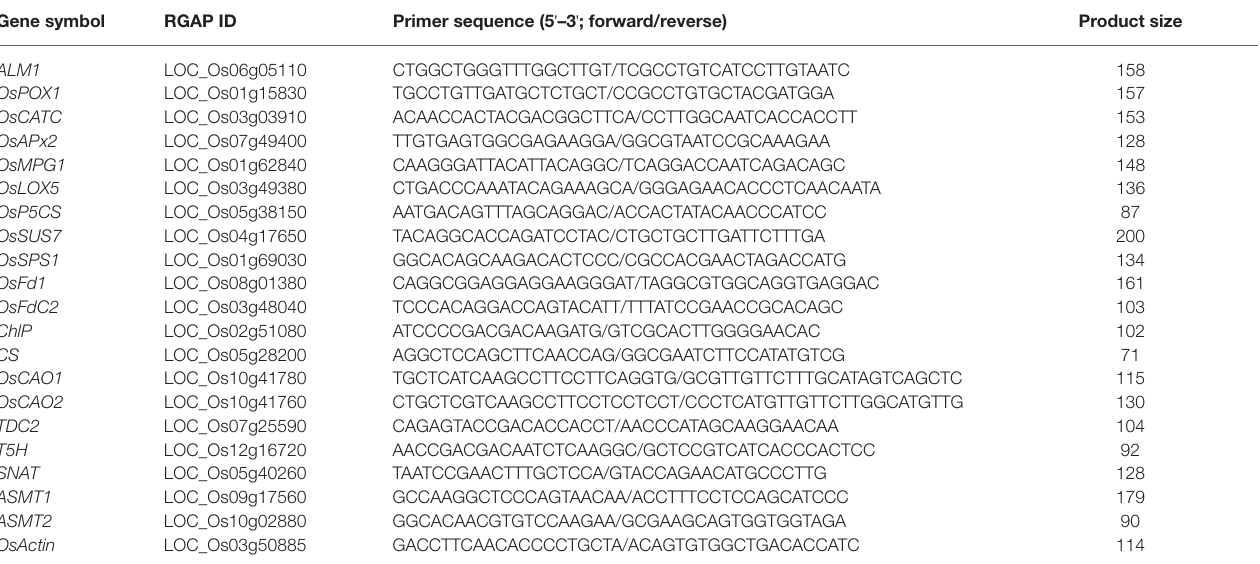
TABLE 1 | Genes examined and RT-qPCR primer sequences. Gene symbol RGAP ID Primer sequence (5 ' –3 ' ;